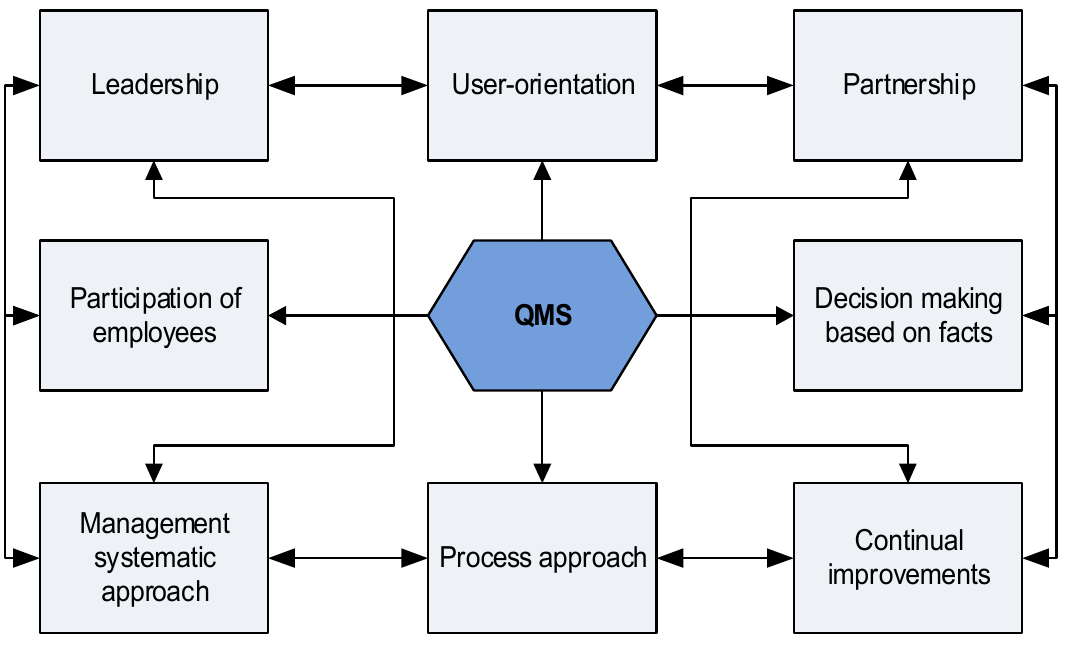
Figure 1. Principle structure of QMS